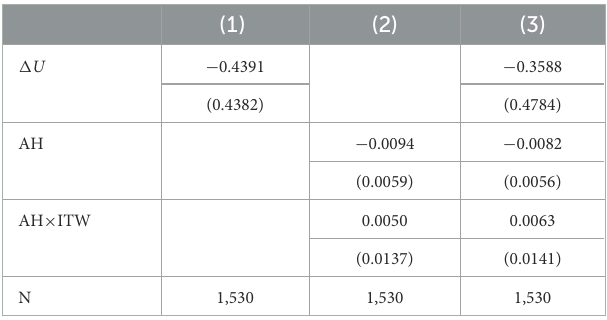
TABLE 7 Assessing the exogeneity of medicaid